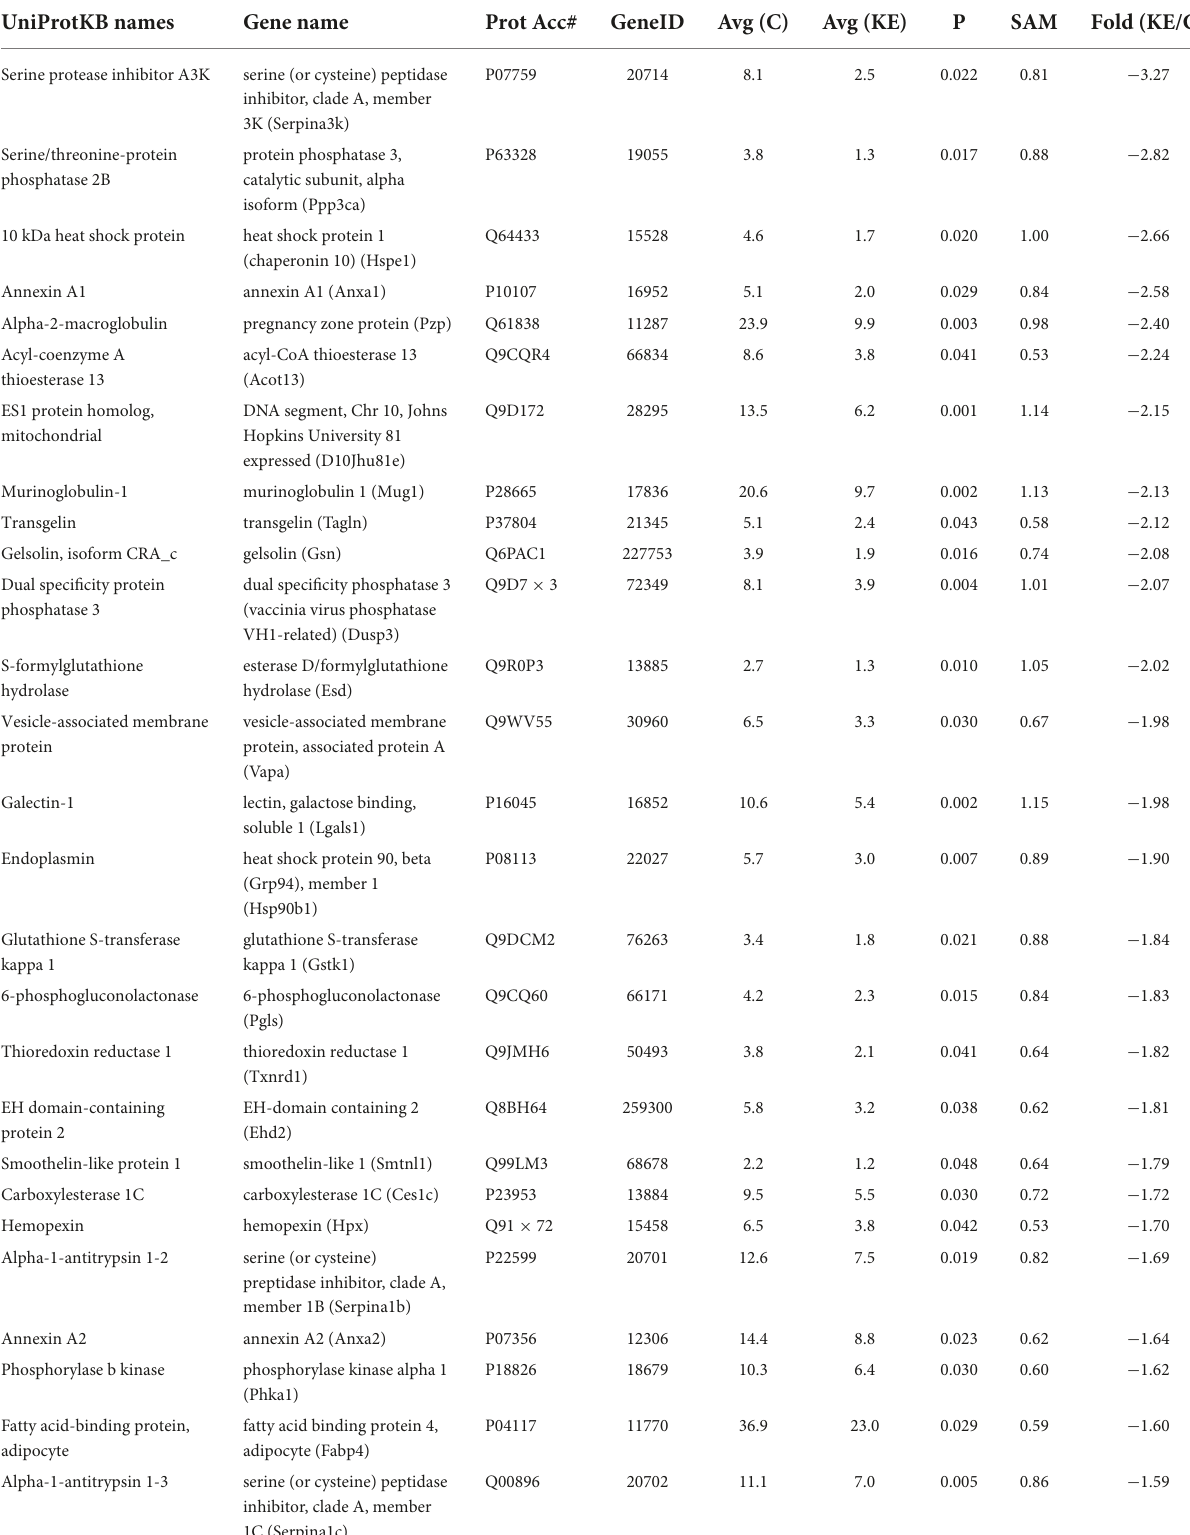
TABLE 5 Proteomic differences in mouse muscle tissues: Ketone ester (KE) vs. control diets 33 proteins were significantly lower in KE compared to